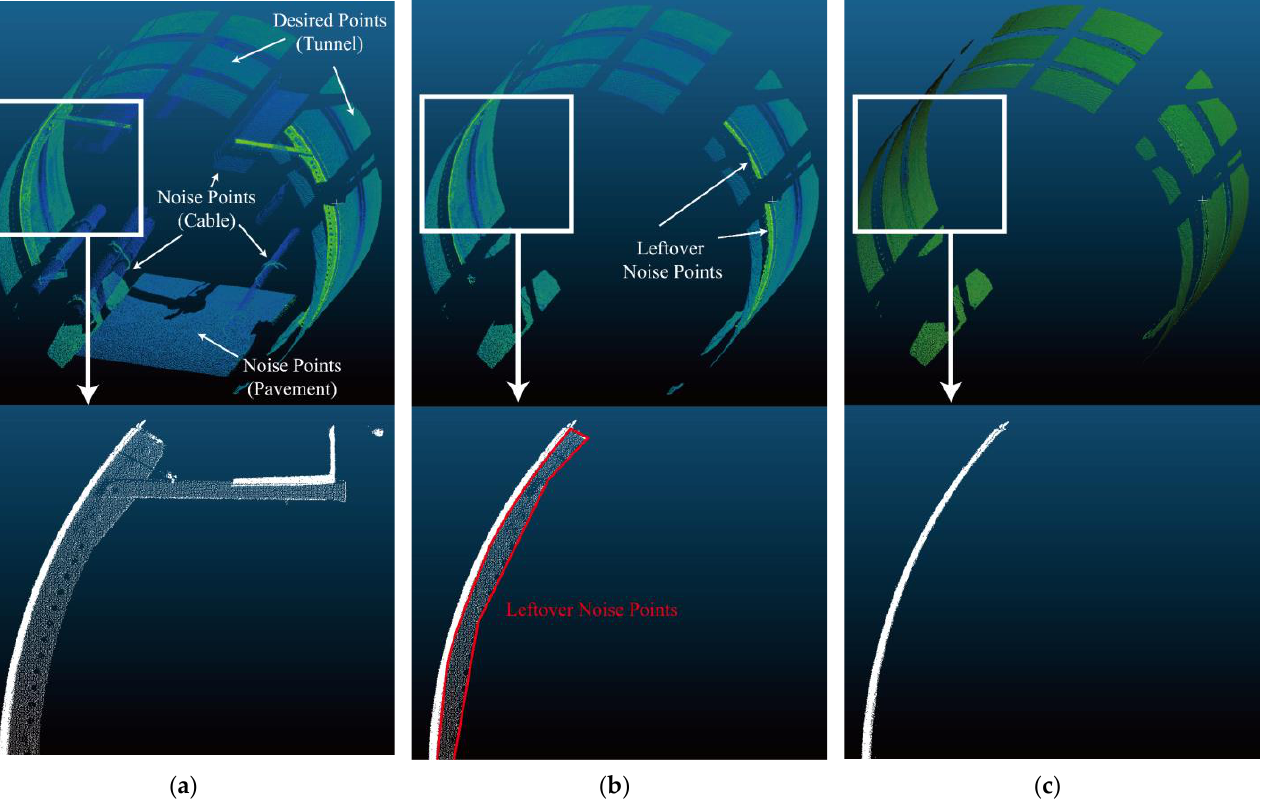
Figure 4. Noise removal result of segmented point cloud: ( a ) Raw segmented point cloud of one tunnel ring; ( b ) Noise points removed by manual operation; ( c ) Leftover noise points removed by RANSAC.